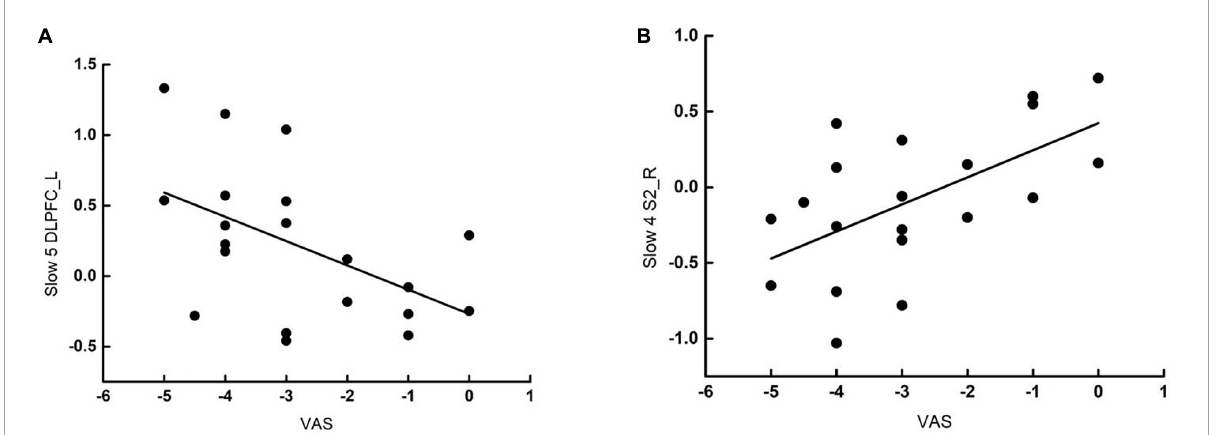
FIGURE3 Correlation analysis following verum acupuncture and VAS scores of PDM. (A) The gFCD changes at Slow-5 band of the left DLPFC in patients with PDM was negatively correlated with the change in VAS scores (r = –0.508, p = 0.022). (B) The gFCD changes at Slow-4 band of the right S2 in patients with PDM was positively correlated with the change in VAS scores (r = –0.587, p = 0.006). gFCD, global functional connectivity density; VAS, visual analog scale; S2, second somatosensory cortex; DLPFC, dorsolateral prefrontal cortex; pINS, posterior INS; aINS, anterior INS; ACC, anterior cingulate